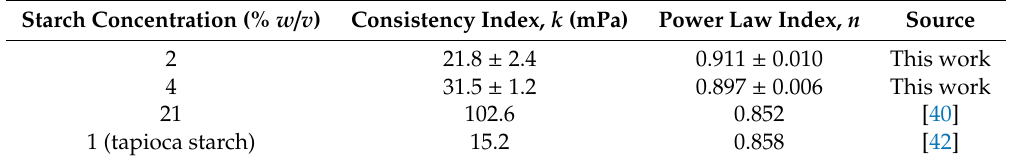
Table 1. Power law parameters for starch at various concentrations.